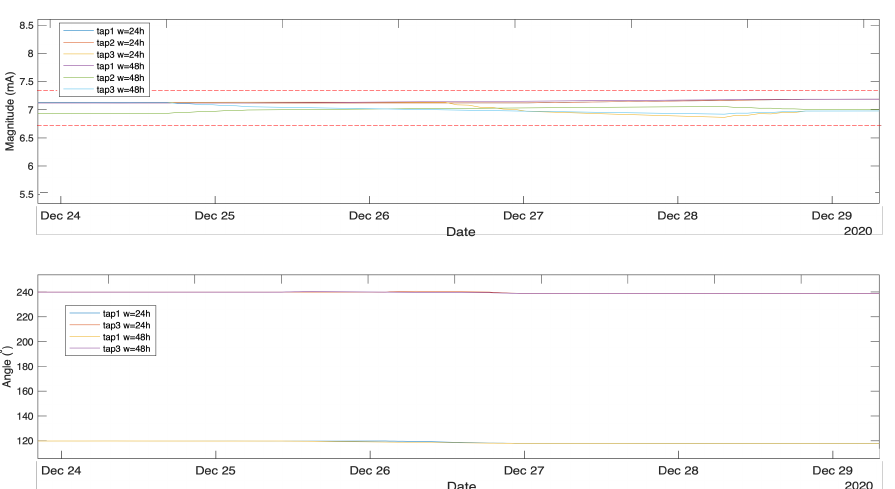
Figure 12. Moving average magnified at first anomaly date, dotted line represents the anomaly